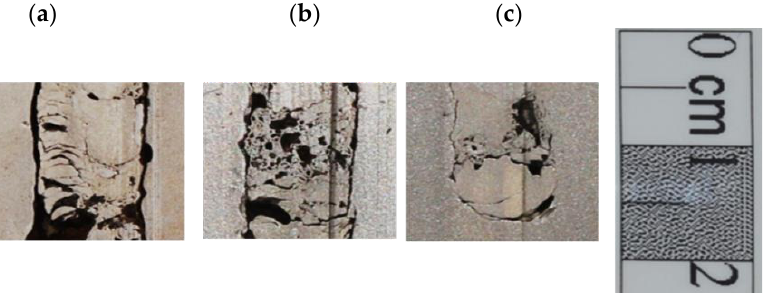
Figure 5. Enlarged fragments of the residual rods inside the penetration channels, which initially were: ( a ) 60 mm, ( b ) and ( c ) 96 mm long.